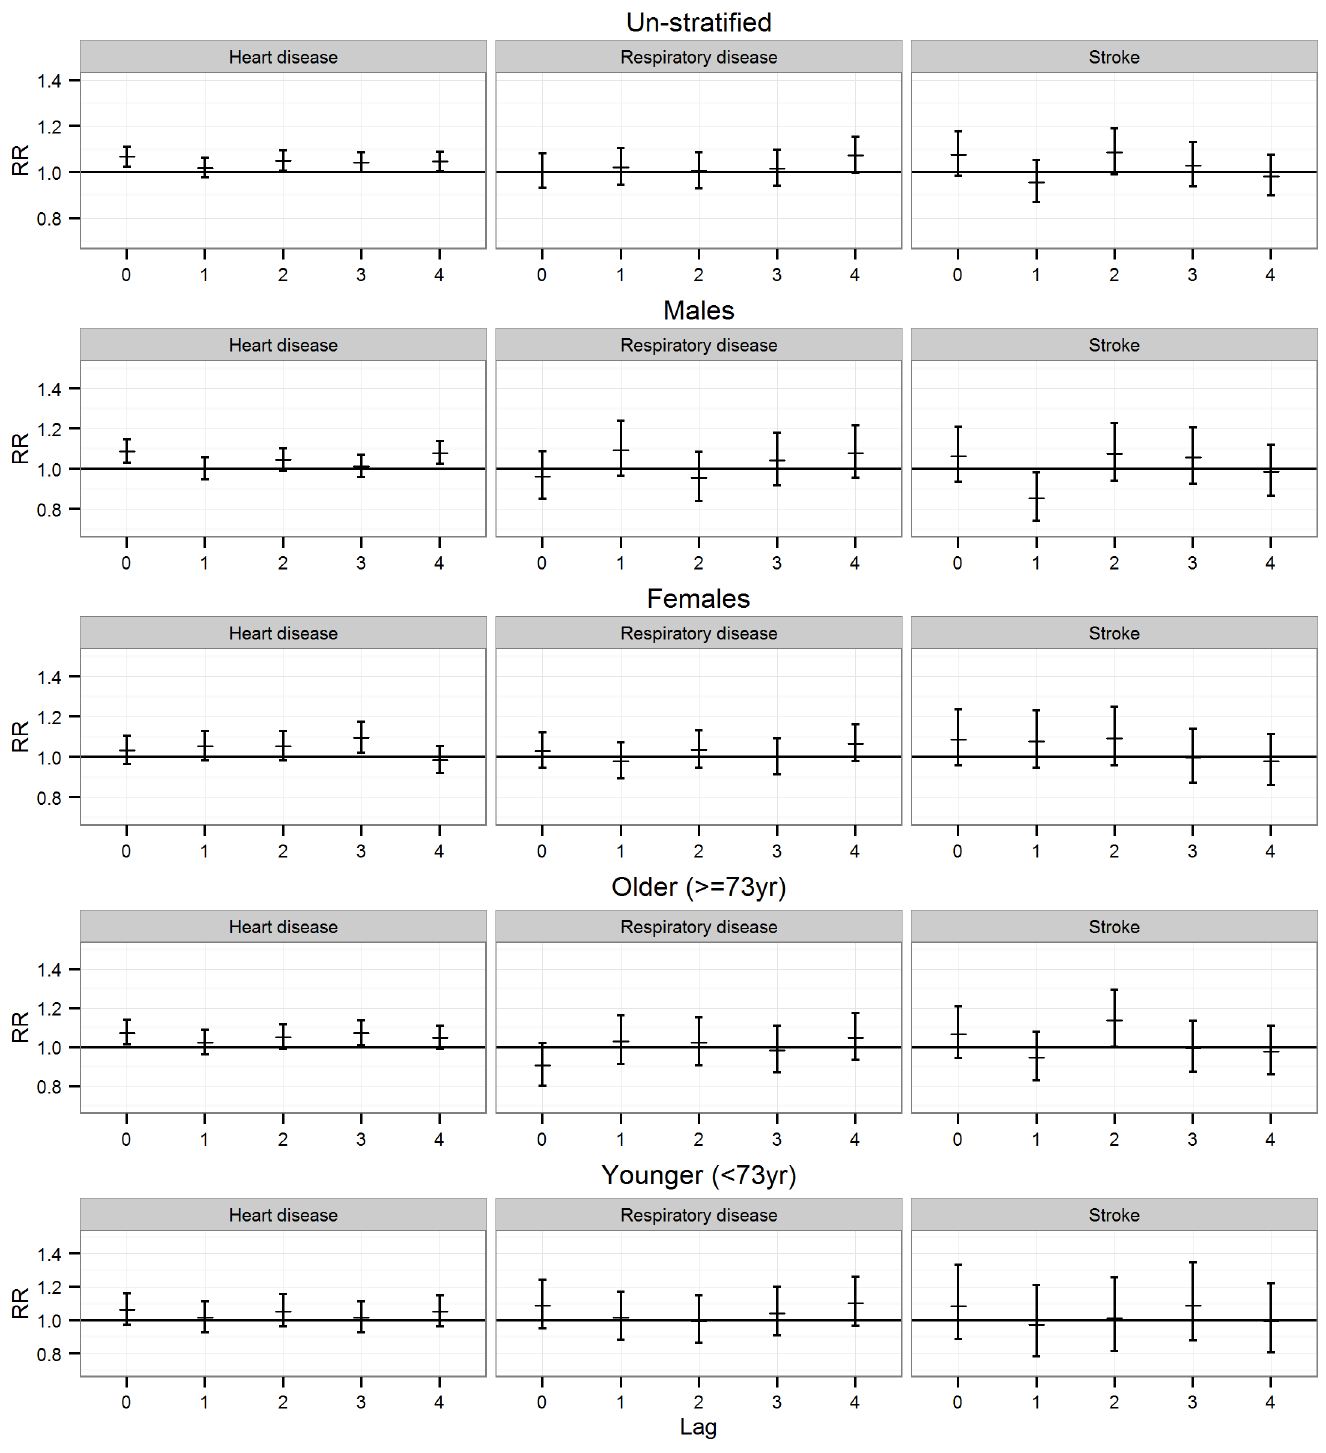
Fig 3. Associations between daily emergency hospital visits with heart diseases, respiratory diseases, and stroke as primary diagnosis and H 2 S concentrations exceeding 7.00 μ g/m 3 in fully adjusted models for lags 0 – 4, un-stratified, and gender and age stratification.